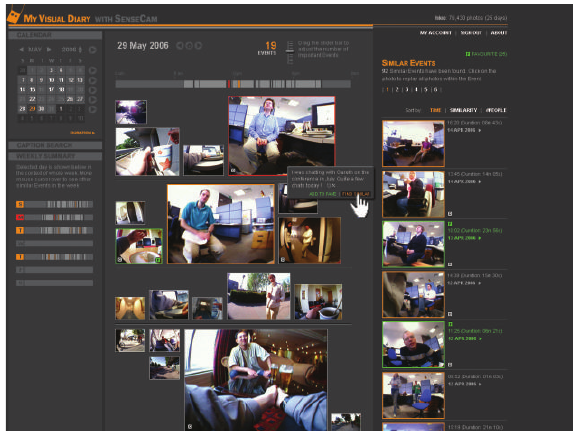
Figure 2: User’s photos are automatically grouped by unique arte- facts and then matched to authoritative photos with the relevant information presented.